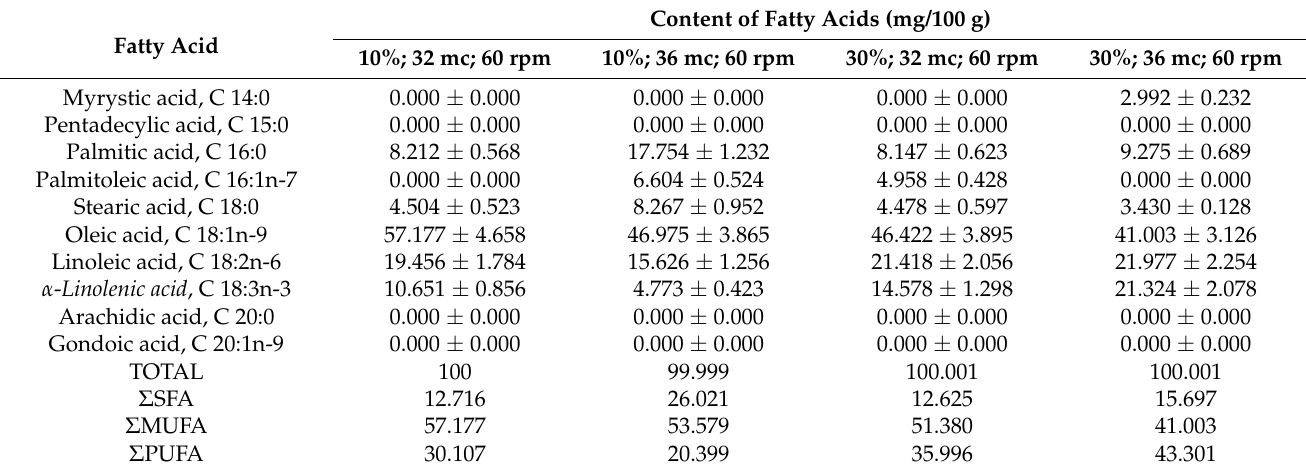
Table 8. Fatty acid profiles of snack pellets processed at a screw speed of 60 rpm.